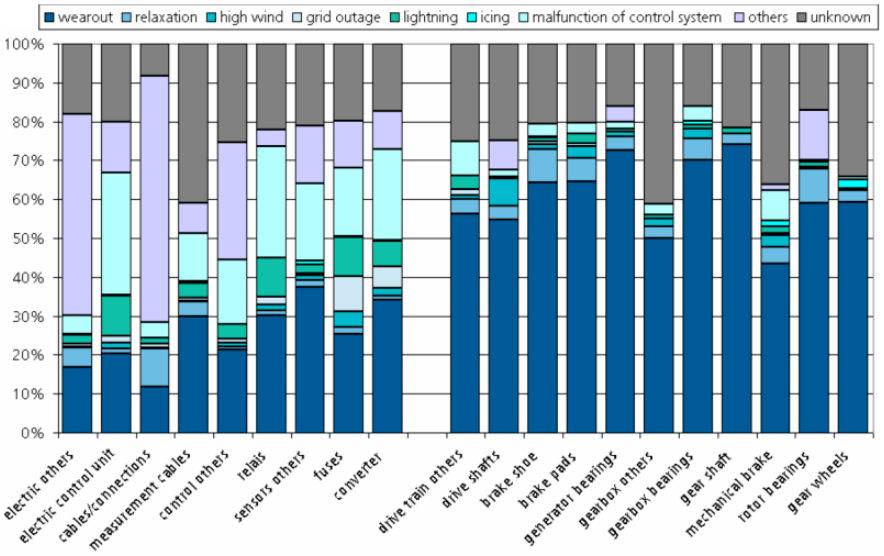
Figure 5. Share of failures in the wind turbine system [65].